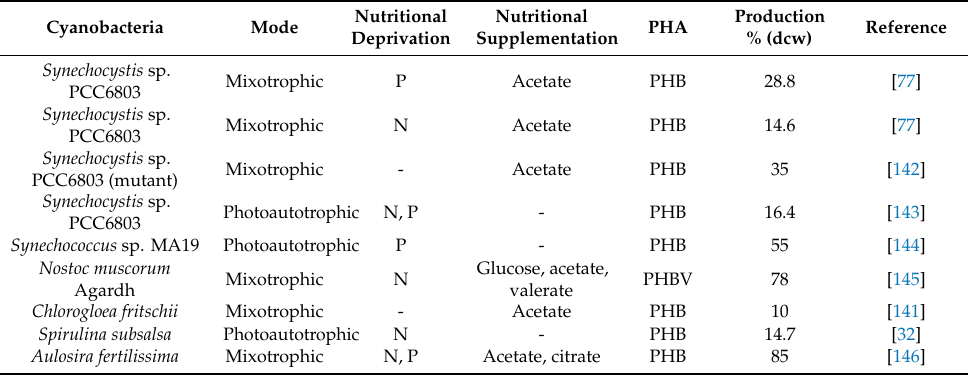
Table1. ExamplesofPHA-producingcyanobacteria, namelyPHBandPHBV,withrespectiveproduction in % (dcw) and nutritional